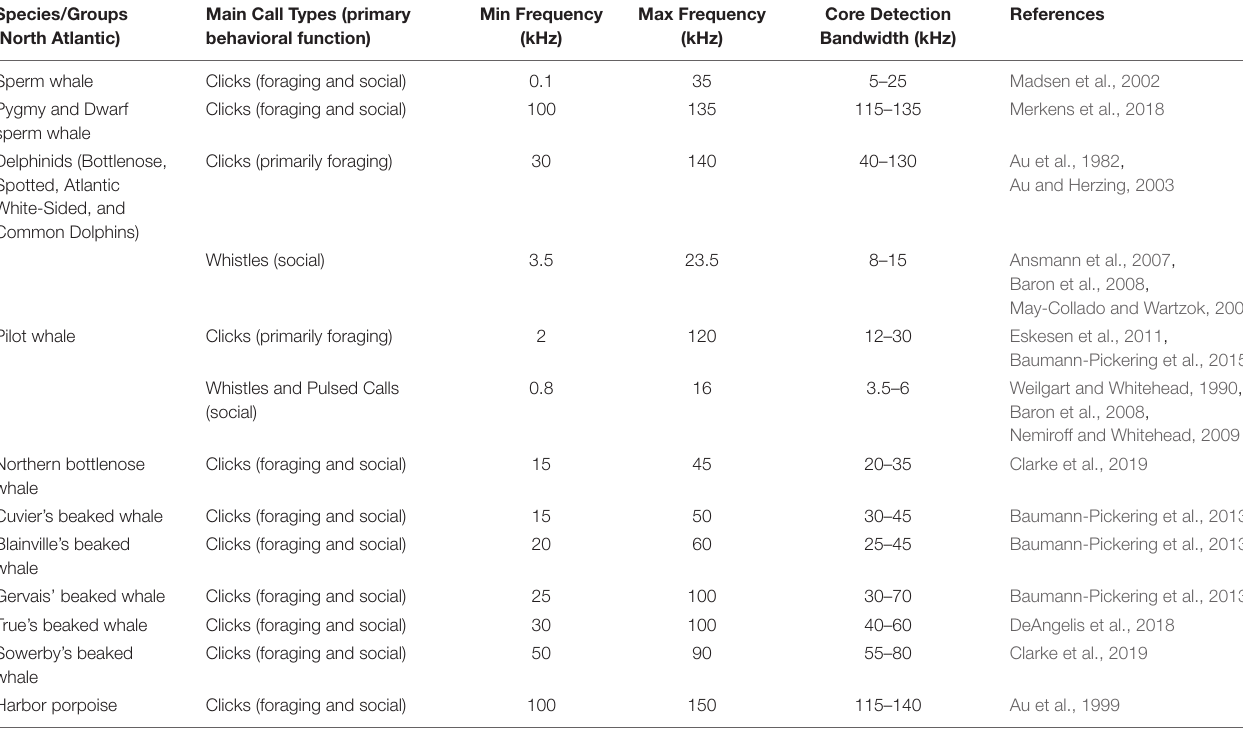
TABLE 2 | A list of the primary odontocete species found along the Atlantic Outer Continental Shelf and their primary call type, frequency range, and core detection bandwidth. Species/Groups (North